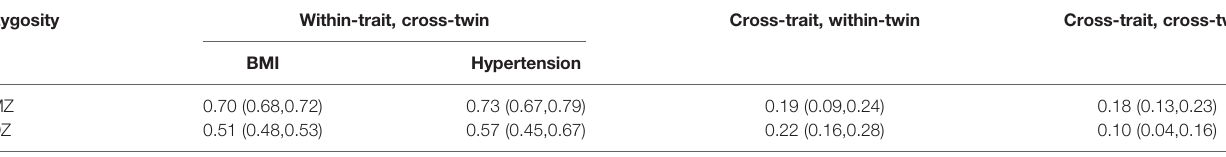
TABLE 5 | Correlations (95% CIs) for BMI, hypertension, and BMI-hypertension by zygosity. Zygosity Within-trait, cross-twin Cross-trait, within-twin Cross-trait, cross-twin